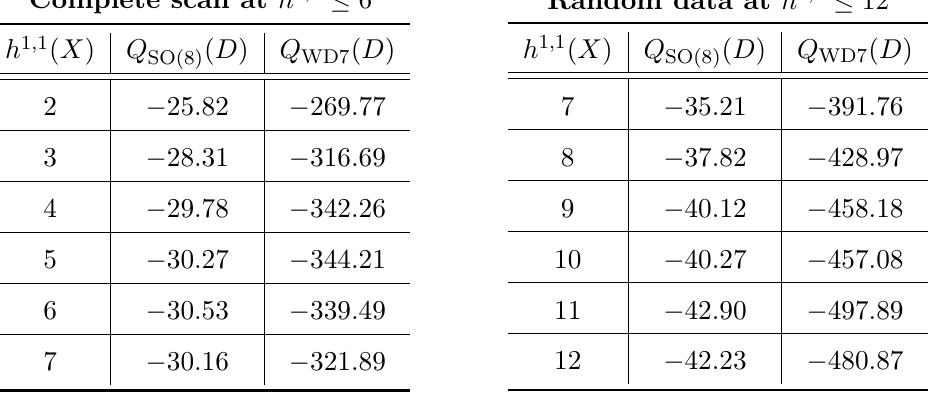
Table 5 . Average D3-charge contribution for local and non-local D7-tadpole cancellation for complete scan (left) and randomise data